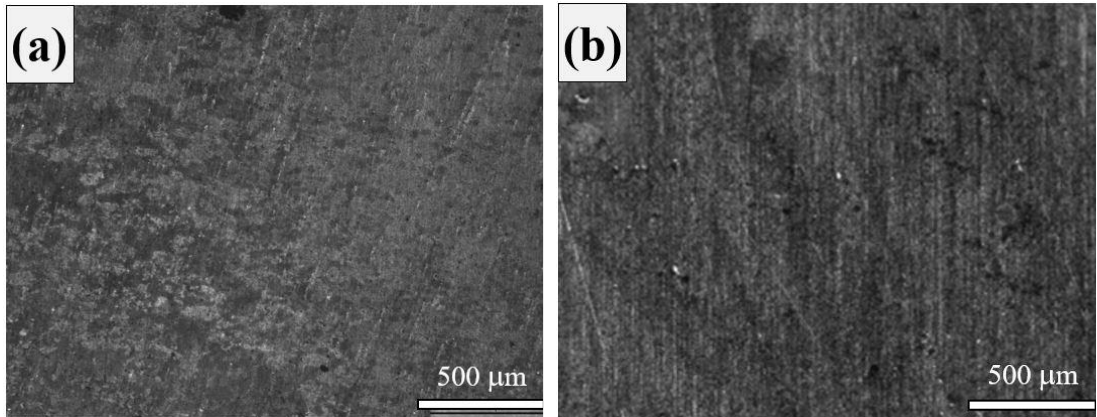
Figure 8. SEM images obtained after immersion in saturated Ca(OH) 2 (pH = 12.5) +0.2% Cl − solutions. ( a ) Standard rebar and ( b ) DP steel. Table 4. EIS results for DP steel and standard rebar in saturated Ca(OH) 2 (pH = 12.5) + 0.2% Cl − solution. Sample